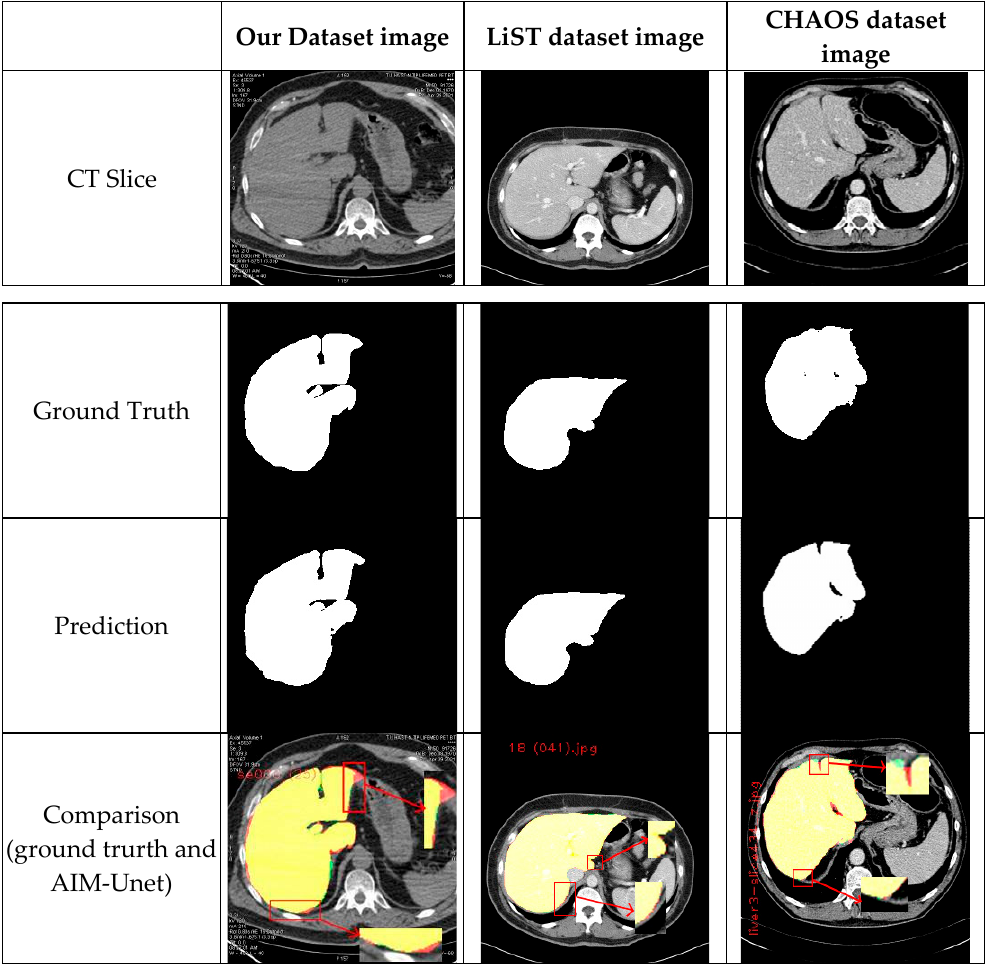
Figure 8. Performance of the proposed model (AIM-Unet) on images of datasets. The red areas in the comparison image show the regions that our model missed, the green areas are the areas that the model predicted incorrectly, and the yellow areas are the regions that the model predicted correctly.